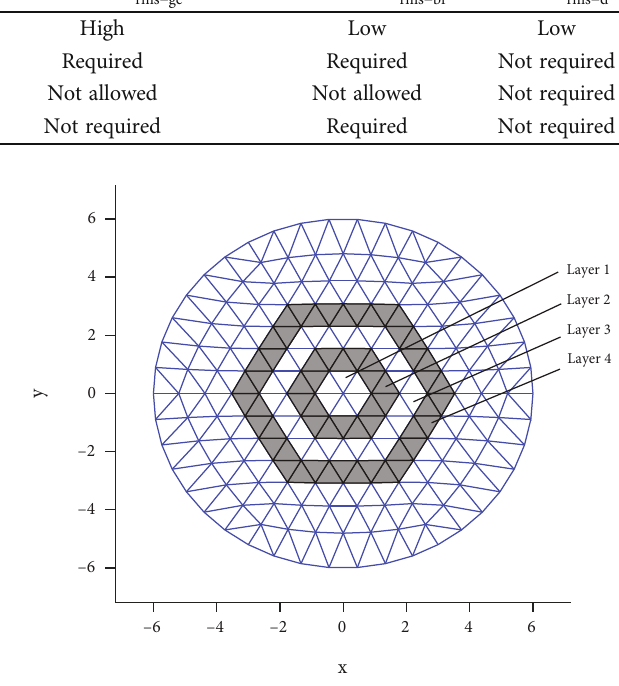
Figure 14: Layers of a mesh geometry of a